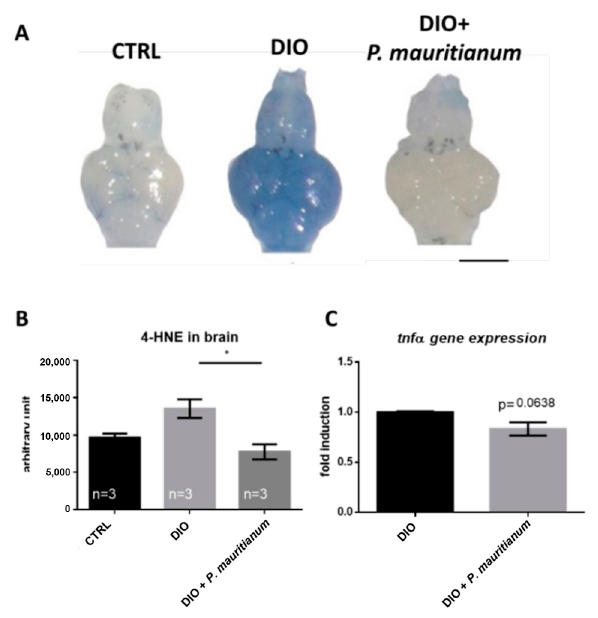
Figure 7. Aqueous extract of P. mauritianum prevents BBB leakage and brain oxidative stress. ( A ) Dorsal views of zebrafish brains after Evans blue dye injection in CTRL, DIO and DIO + P. mauritianum -treated fish. Zebrafish brains remained mostly white, except for the DIO brains. Note that in DIO, the blue staining is heterogeneous between fish. ( B ) Dot blot quantification showing that the P. mauritianum treatment in DIO fish prevented the cerebral increase in 4-HNE levels induced by overfeeding. ( C ) qPCR gene expression analysis of tnf α in DIO and DIO + P. mauritianum. n = 5–6 number of fish brains studied for ( A ), n = 3 pools of 2 brains for ( B , C ). Bar graph: standard error of the mean (SEM). Student’s t-test for ( B , C ): * p < 0.05. Bar: 0.8 mm.